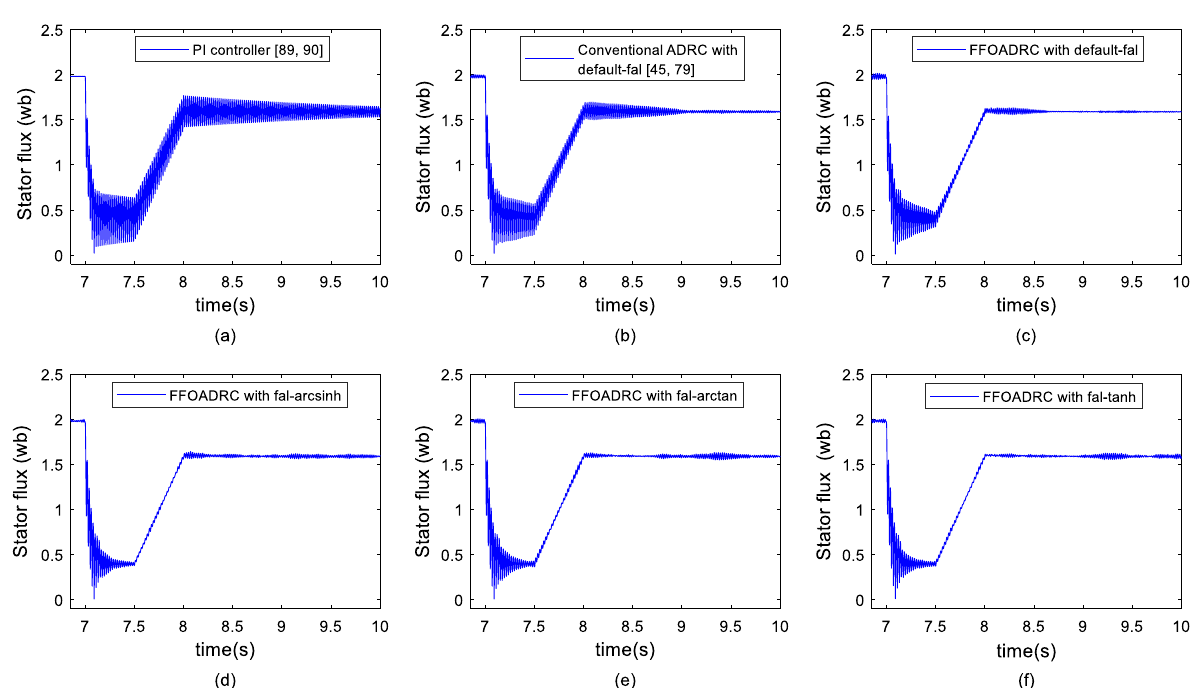
Fig. 15 Stator flux during symmetrical voltage sag for R crowbar 0.01 Ω: ( a ) PI controller [89, 90], ( b ) Conventional ADRC with default-fal [45, 79], ( c ) = FFOADRC with default-fal, ( d ) FFOADRC with fal-arcsinh, ( e ) FFOADRC with fal-arctan, and ( f ) FFOADRC with